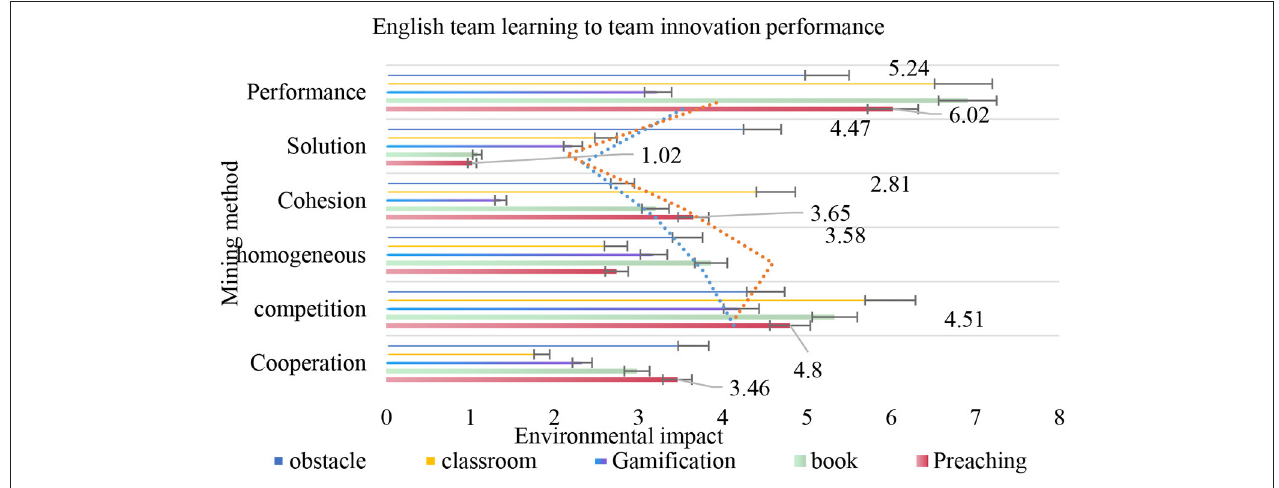
FIGURE 5 | English team learning to team innovation performance.